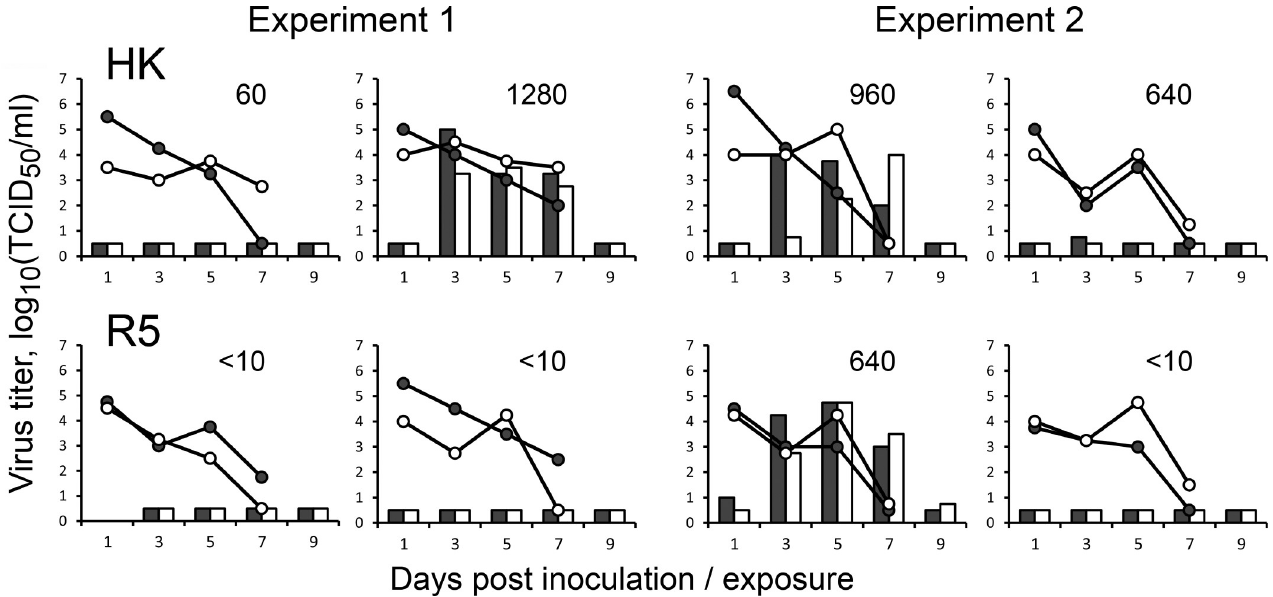
Fig 9. Comparison of airborne transmission of HK and R5 in ferrets. Groups of two ferrets were inoculated intranasally with 10 6 TCID 50 of recombinant viruses HK (top panels) and R5 (bottom panels) containing all eight gene segments of A/Hong Kong/1/1968. One na ï ve ferret was co-housed with each inoculated ferret in a separate transmission cage starting from one day after inoculation. Data show results of two replicate experiments performed on different days. Lines depict viral titers in nasal swabs (empty circles) and throat swabs (closed circles) collected from inoculated ferrets. White and black bars depict viral titers in nasal and throat swabs, respectively, of the indirect contact ferrets. Numbers show titers of hemagglutination inhibiting antibodies in the blood collected from the indirect contact animals 2 weeks post exposure.